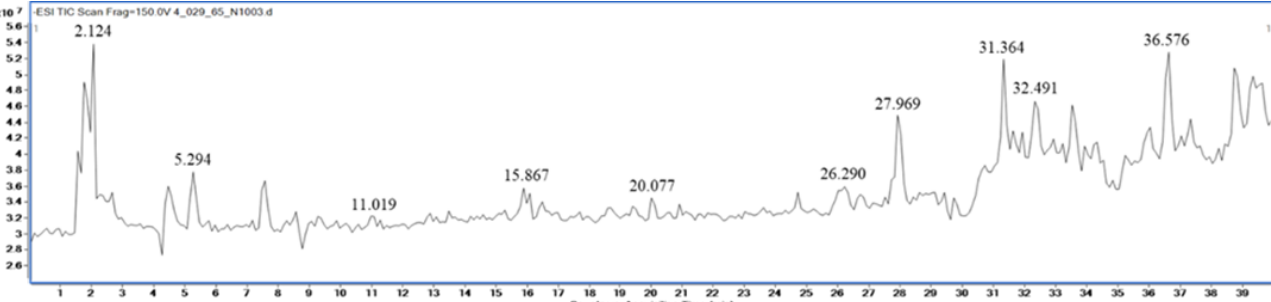
Figure 1. LC-MS chromatogram of ethanolic M. fragrans mace extract.